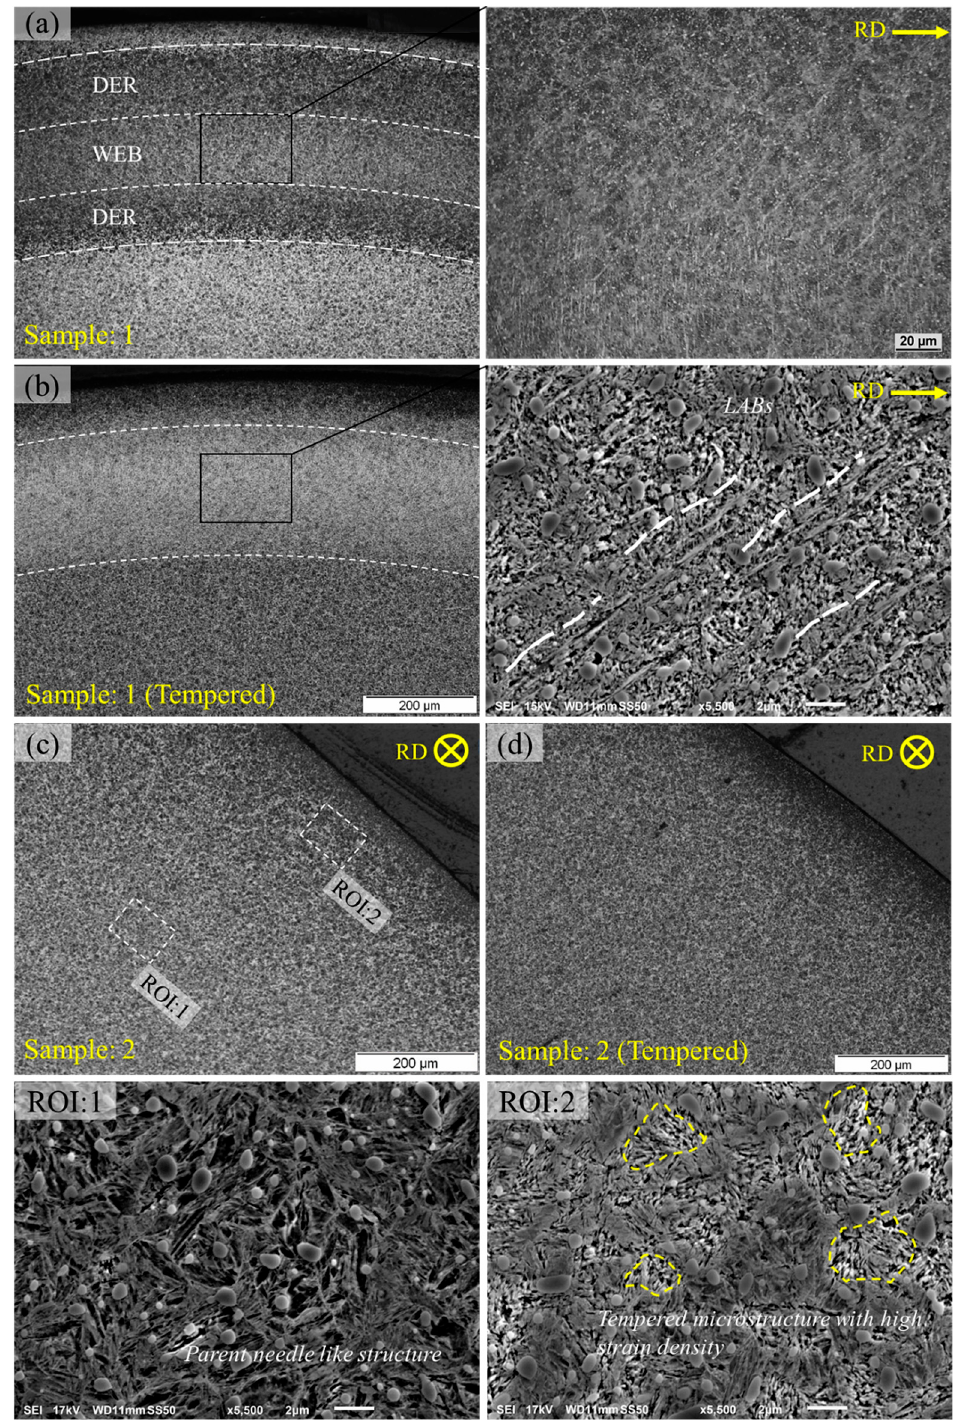
Figure 2. ( a ) Subsurface micrographs obtained at 6 GPa, 100 °C, after 37 million rolling cycles. ( b ) Tempering of RCF ‐ tested sample shown in ( a ). ( c ) Micrographs obtained at 6 GPa, 100 °C, after 0.02 × 10 6 rolling cycles. ( d ) Tempering of RCF ‐ tested sample shown in ( c ). ROI:1 and ROI:2 represent regions of interest for parent structure and RCF damaged area respectively.